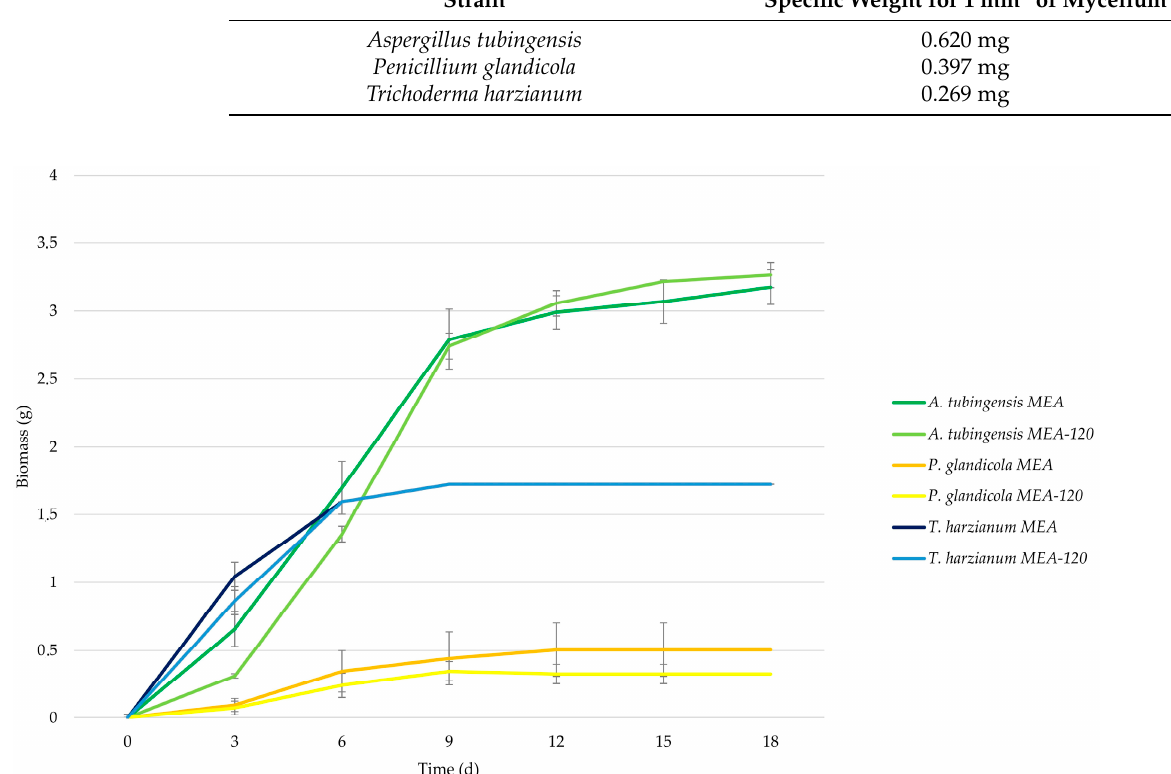
Figure 2. Fungal biomass growth during the dish tests on medium enriched with e-waste powder MEA-120 and control MEA.